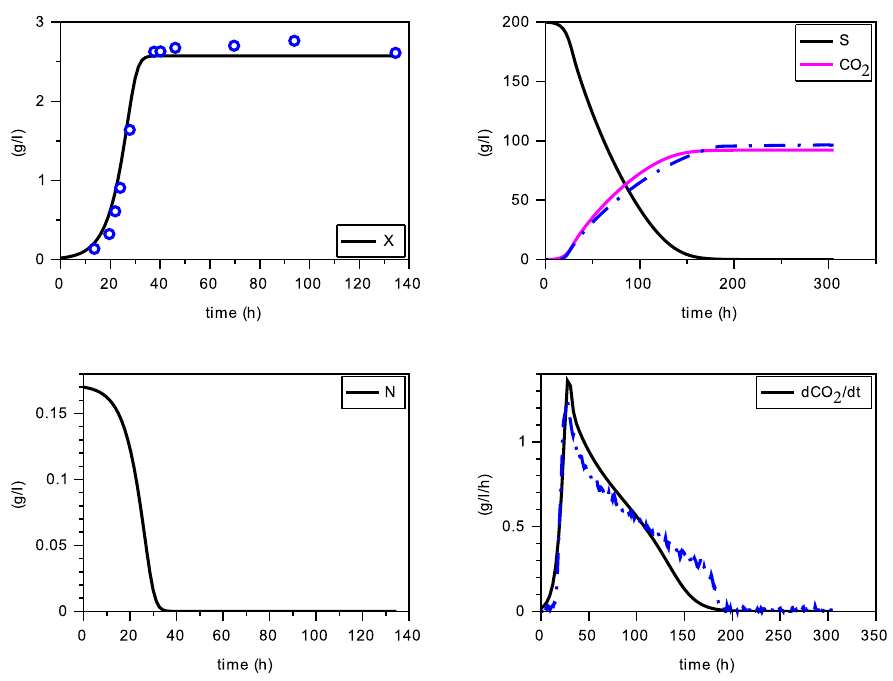
Figure 14. Simulation for N ( 0 ) = 0.170 g · L − 1 (experimental data in blue).